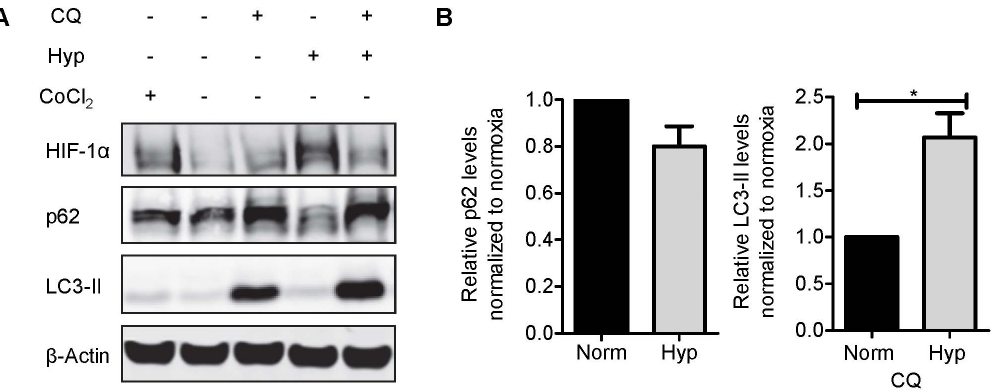
Figure 5. Hypoxia activates autophagy in CD8 T cells. (A) A representative Western blot indicating protein expression of HIF-1 a , p62, LC3-II and b -actin is shown for OT-I CD8 T cells cultured under 1.5% oxygen. Cobalt chloride (CoCl 2 ) treatment was used as a positive control for HIF-1 a protein expression. (B) Autophagy induction is shown by quantification of decreasing p62 levels without chloroquine (CQ) treatment and (C) LC3-II accumulation with CQ treatment under normoxia (norm) or 1.5% oxygen (hyp). The mean and standard error of the mean for the fold change of 3 independent experiments is reported. Statistical significance was determined using a one-sample t-test on log transformed values compared to a hypothetical mean of zero. * p ,